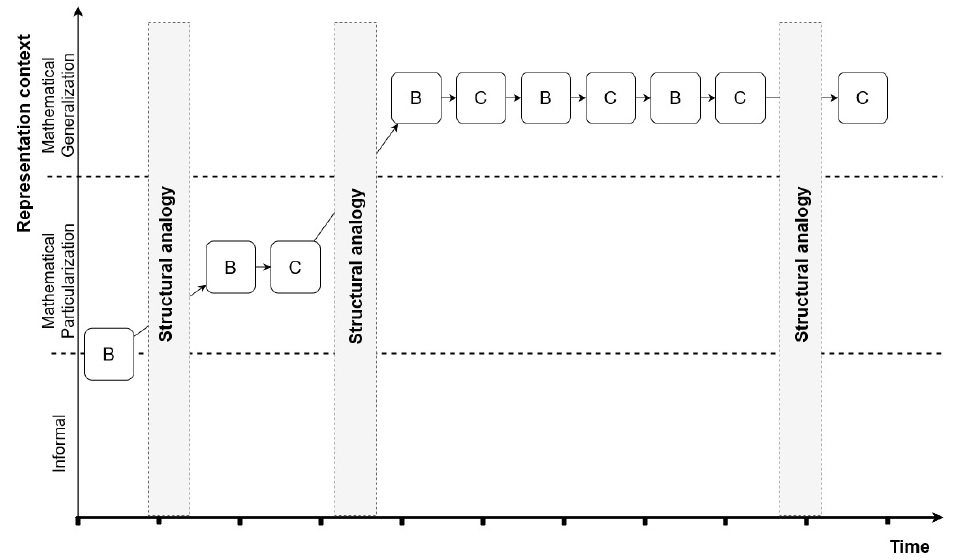
Figure 8. Pattern in epistemic actions and context (second excerpt diagram).